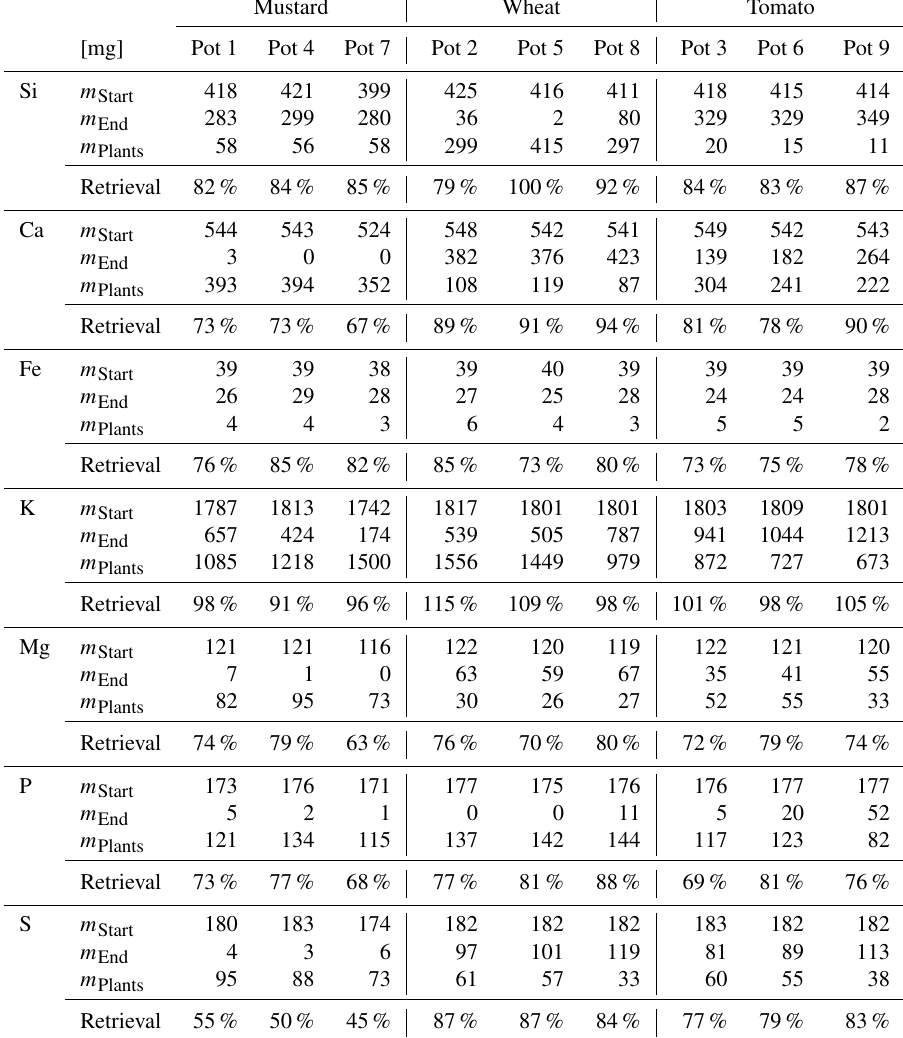
Table 3. Major element budget for mustard, tomato, and wheat. m Plants is calculated based on the concentration of the element in the plant digest and the dry mass. The m Start and m End are the element masses in milligrams based on the amount of nutrient solution and the element concentration at the start and the end of the experiment. Retrieval is the ratio between m Start and the sum of m Plants and m End . The initial amount of the elements in the seeds, taken up during germination, and the amount of element discharged in the wash water are not